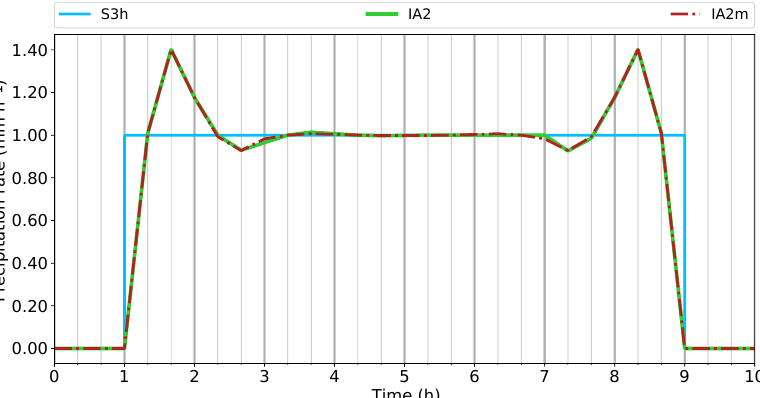
Figure 12. Same as Fig. 11 but comparing only IA2 (green line) and the modified version IA2m (red; dashed–dotted). It is recommended to zoom in to see the differences